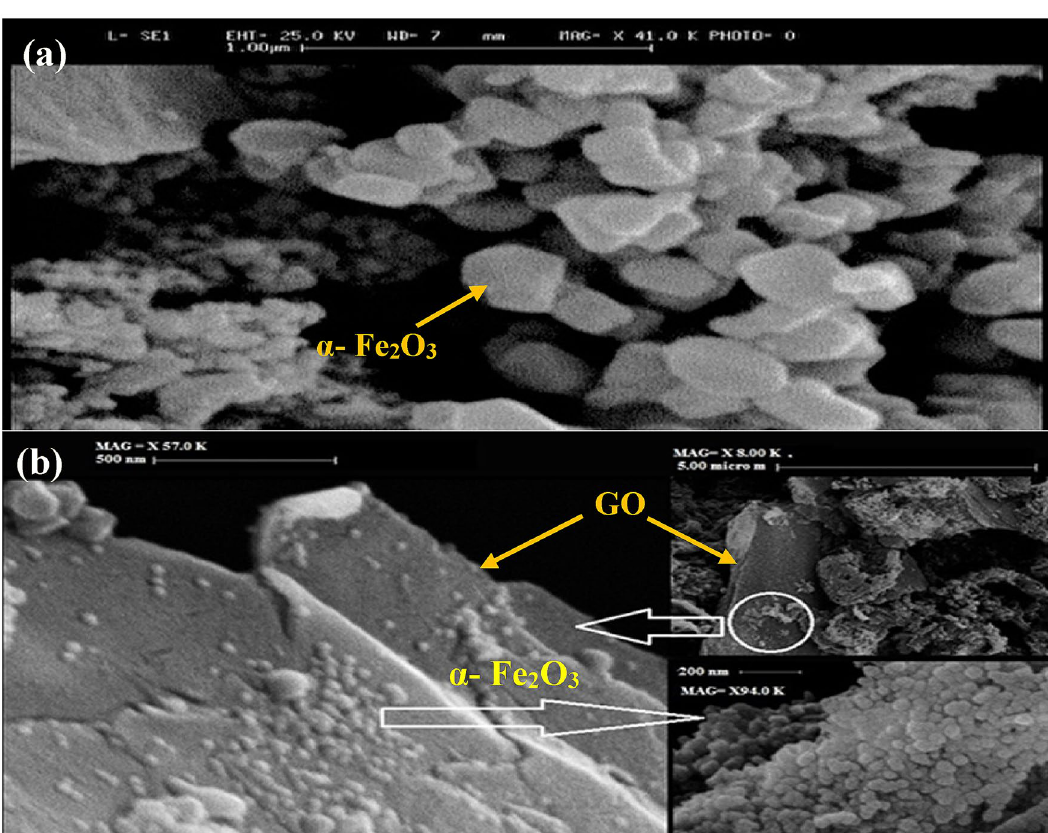
Figure 6. FESEM analysis of nanoparticles of α-Fe2O3 ( a ) and nanocomposite α-Fe2O3-5% GO ( b